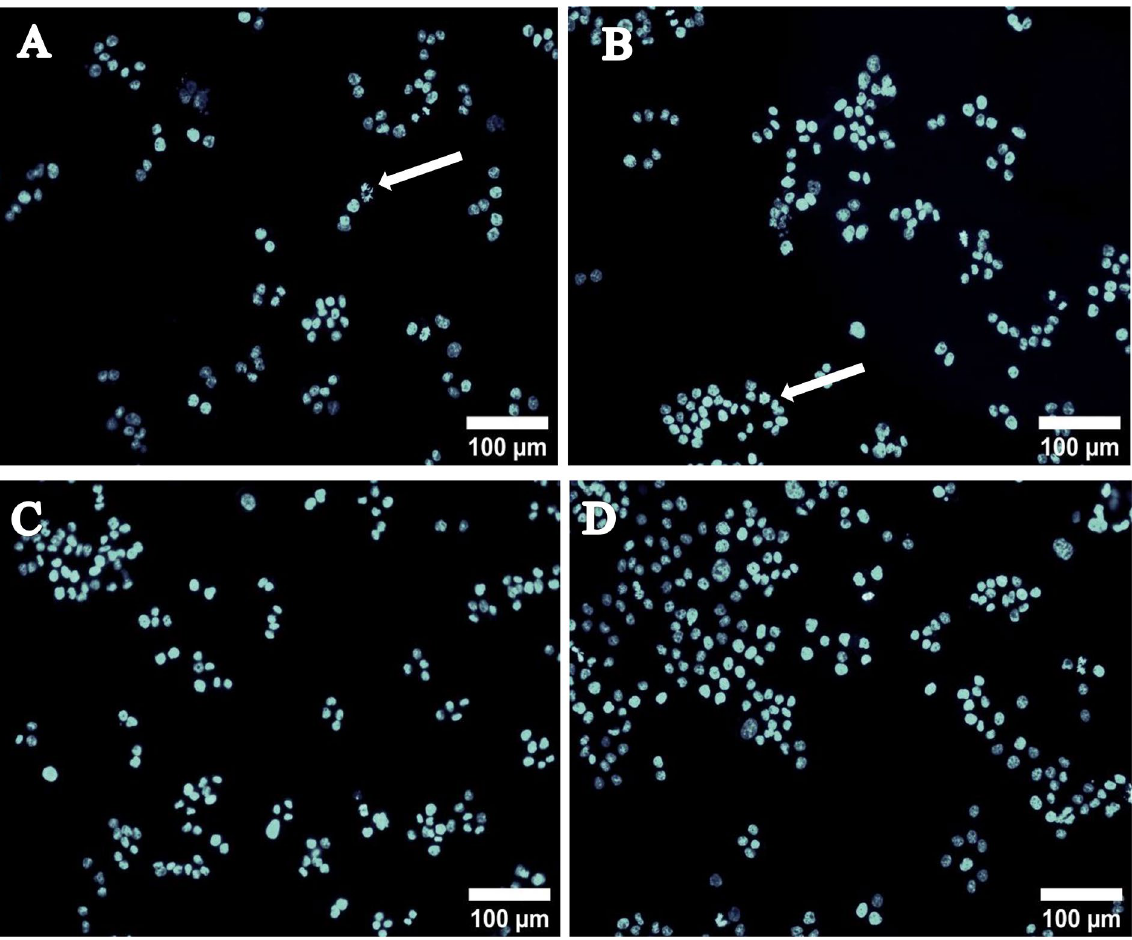
Figure 8. DAPI stained fluorescent images of MDA-MB-231 cells treated at a concentration of 40 µM for 24 h, ( A ) CUR-NPs 7:3, ( B ) CUR-NPs 6:4, ( C ) CUR only, ( D )